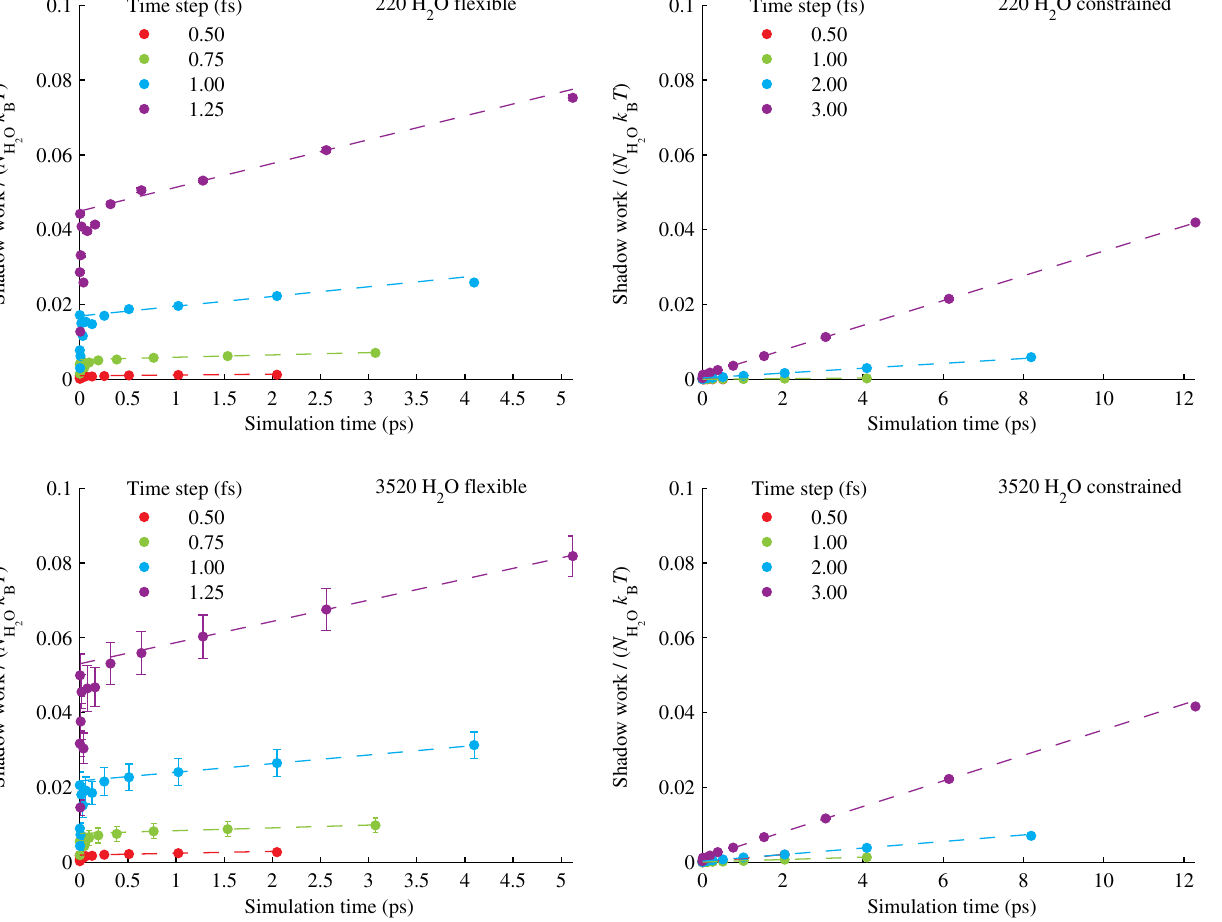
FIG. 4. Convergence to steady state of Langevin simulations with a time-independent Hamiltonian. Shadow work accumulates at a steady rate after M ¼ 1024 steps. Each dashed line connects work values at 1024 and 2048 steps. According to Eq. (A1), the nonequilibrium free energy is estimated as half the y intercept of the dotted line. Left column: unconstrained simulations; right column: constrained simulations. Top row: 220 water molecules; bottom row: 3520 water molecules. Each simulation ran for 4096 steps. Error bars denote 95% confidence